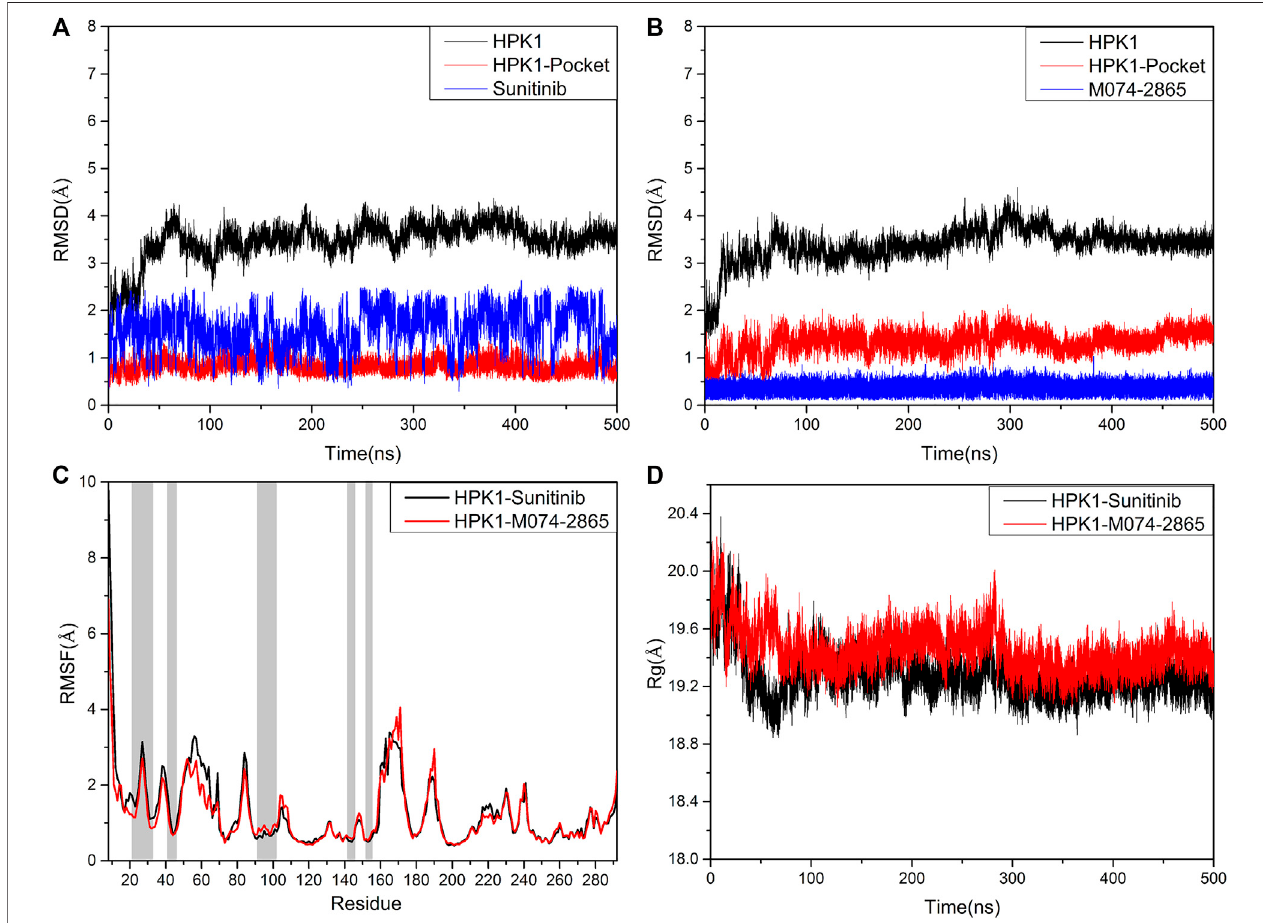
FIGURE 5 | (A) RMSD of the backbone atoms of HPK1 kinase, the backbone atoms of HPK1 kinase pocket, and the heavy atoms of sunitinib. (B) RMSD of the backbone atoms of HPK1 kinase, the backbone atoms of HPK1 kinase pocket, and the heavy atoms of compound M074-2865. (C) RMSF values of HPK1 residue backbone atoms. (D) Mass-weighted radius of gyration.